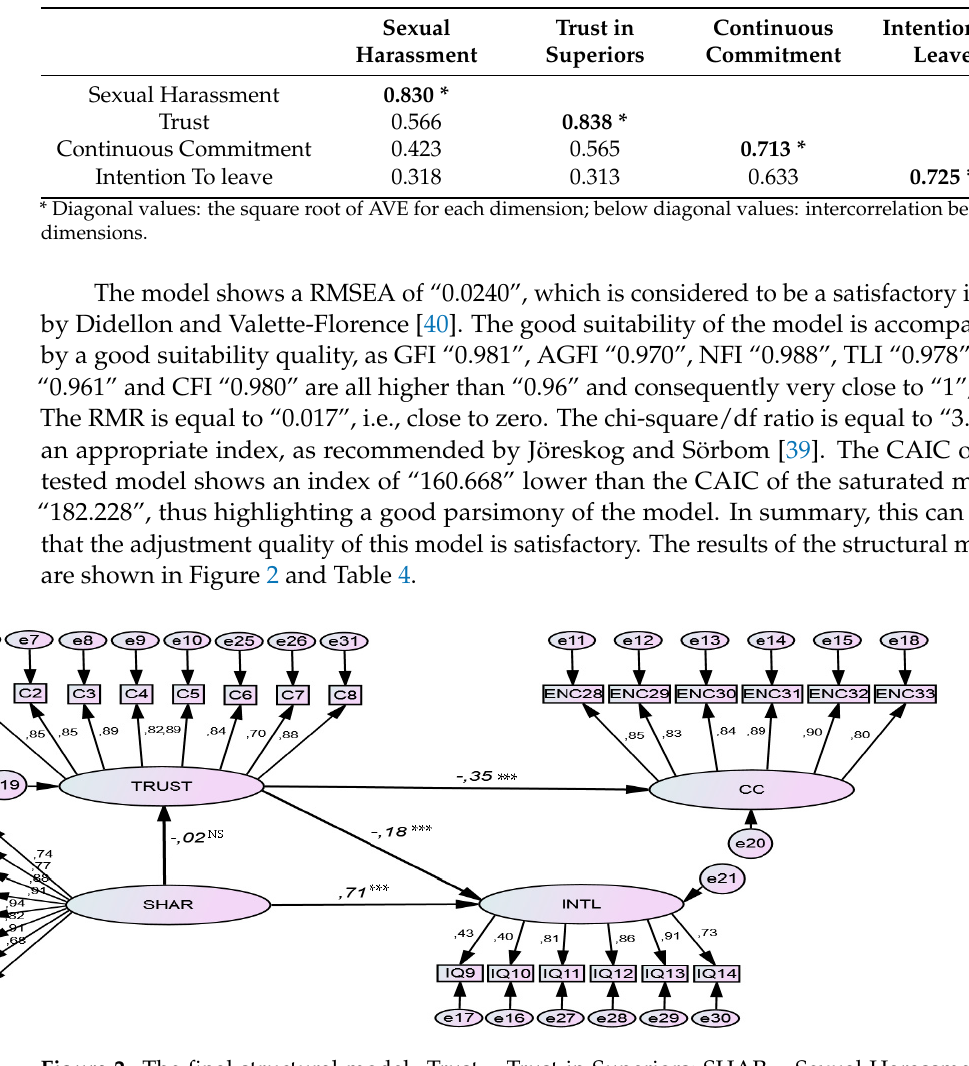
Table 3. Discriminant validity.